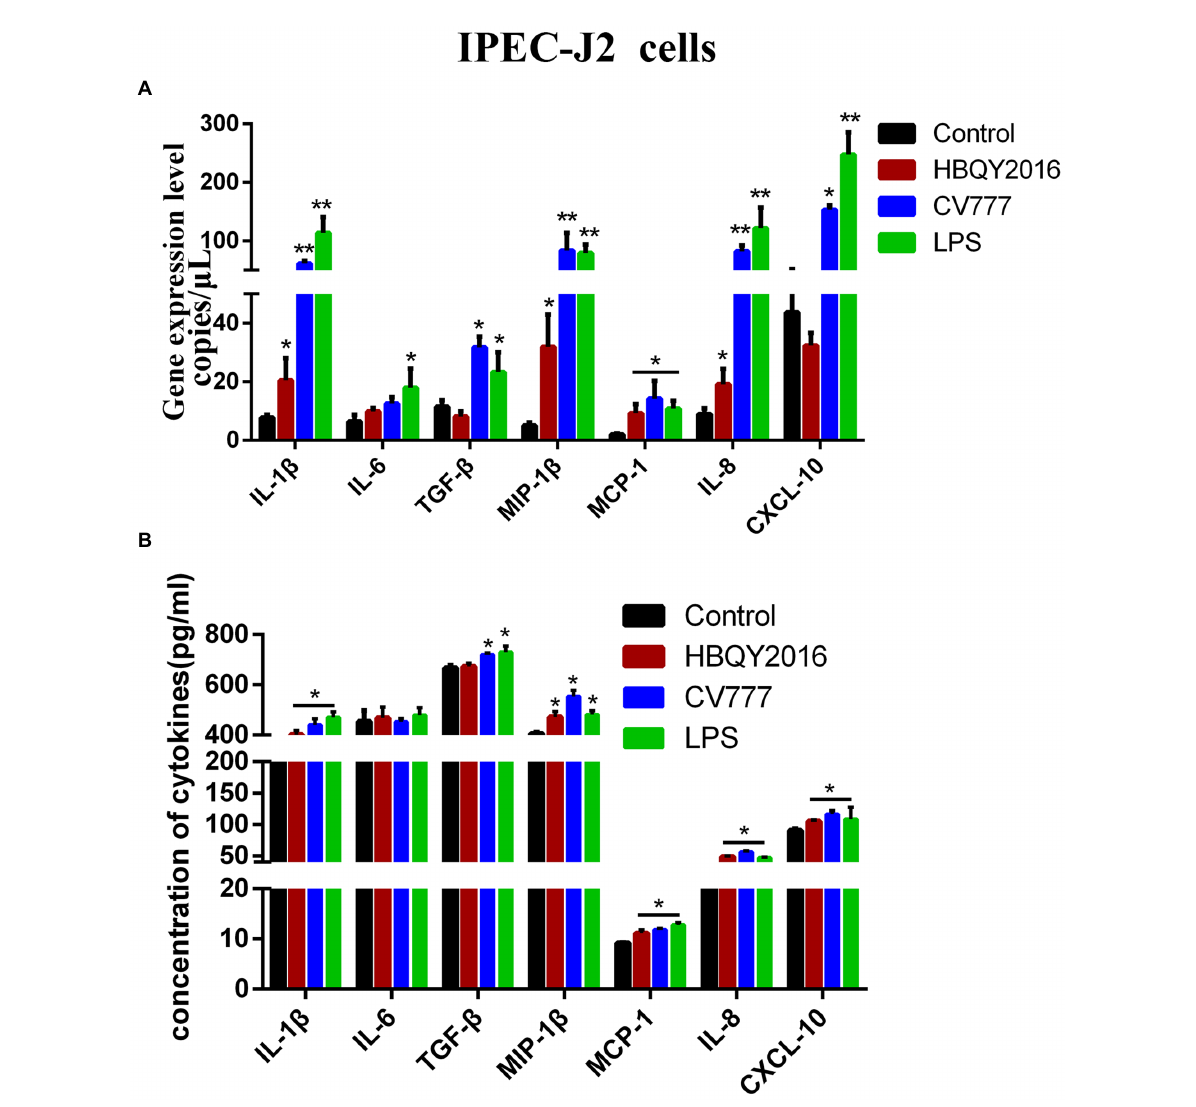
FIGURE 4 Cytokines expression in IPEC-J2 cells infected with PEDV. (A) Changes of gene copies of IL-1 β , IL-6, TGF- β , MIP-1 β , MCP-1, IL-8, and CXCL-10 gene expression in IPEC-J2 cells after PEDV infection. (B) Protein concentration of the cytokines secreted by PEDV-infected IPEC-J2 cells. The supernatant of IPEC-J2 cells was collected at 24 h after infection with 0.1 MOI PEDV, and the cytokine secretion level was detected by ELISA. *Represents a significant difference relative to the control group ( p < 0.05), **Represents an extremely significant difference relative to the control group ( p <